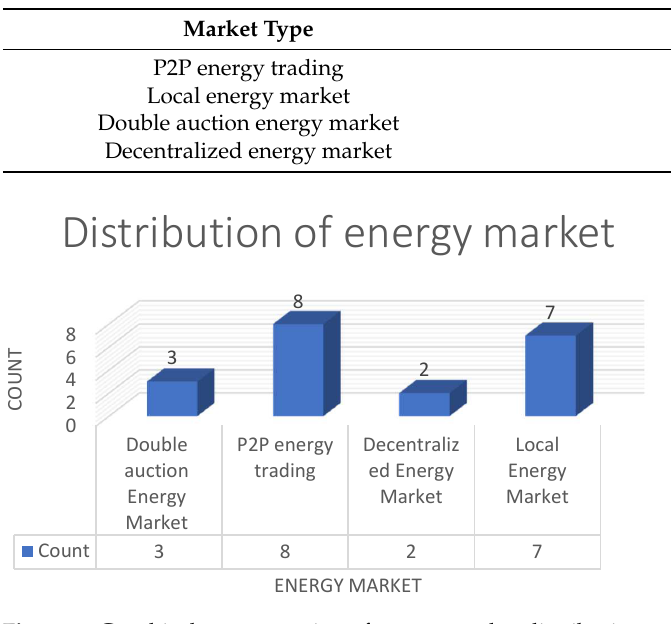
Table 3. Market type distribution.